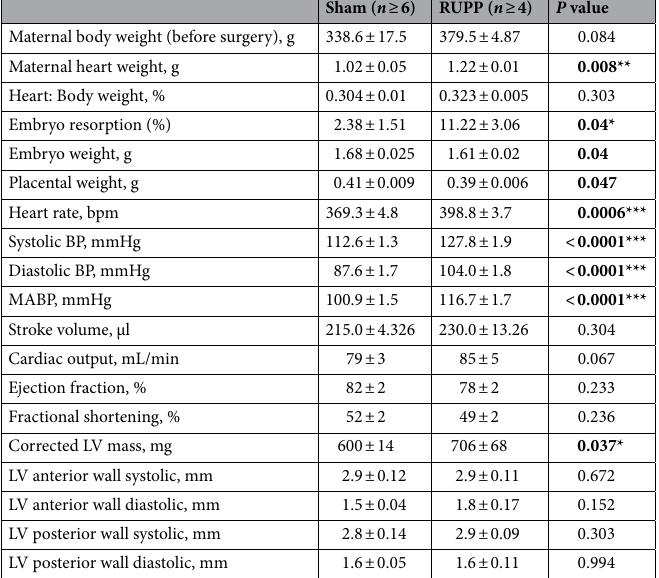
Table 1. Morphological features and cardiac function characteristics of the RUPP model (maternal and fetal). Unpaired Student’s t-test or Mann–Whitney test were used depending on data distribution. This figure was originally published in Biology of Sex Differences and used with permission 26 (https:// doi. org/ 10. 1186/